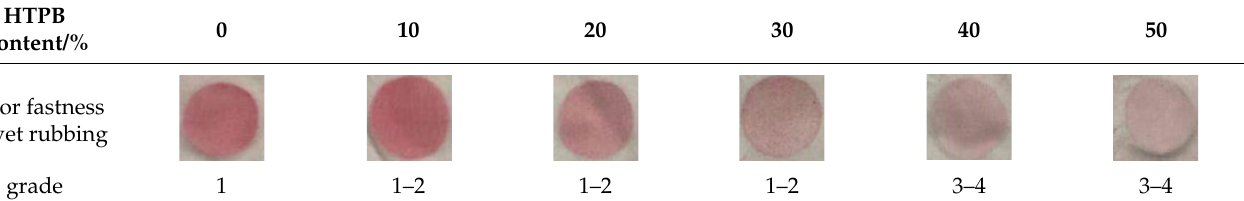
Table 12. Color binding upon wet rubbing of the modified microfiber leather.